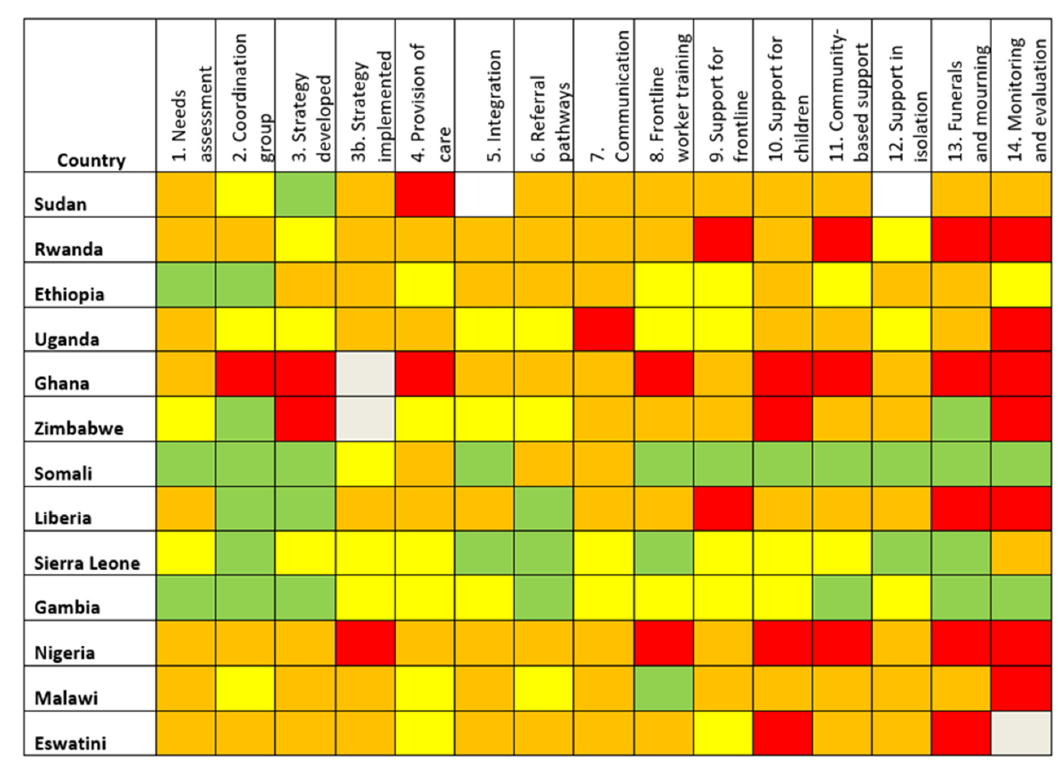
Figure 1. Anglophone countries’ responses to survey based on IASC 14 recommended MHPSS activities in the COVID-19 outbreak.